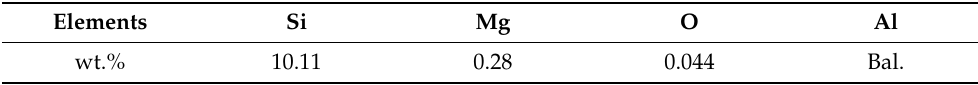
Table 1. Composition of AlSi10Mg powder